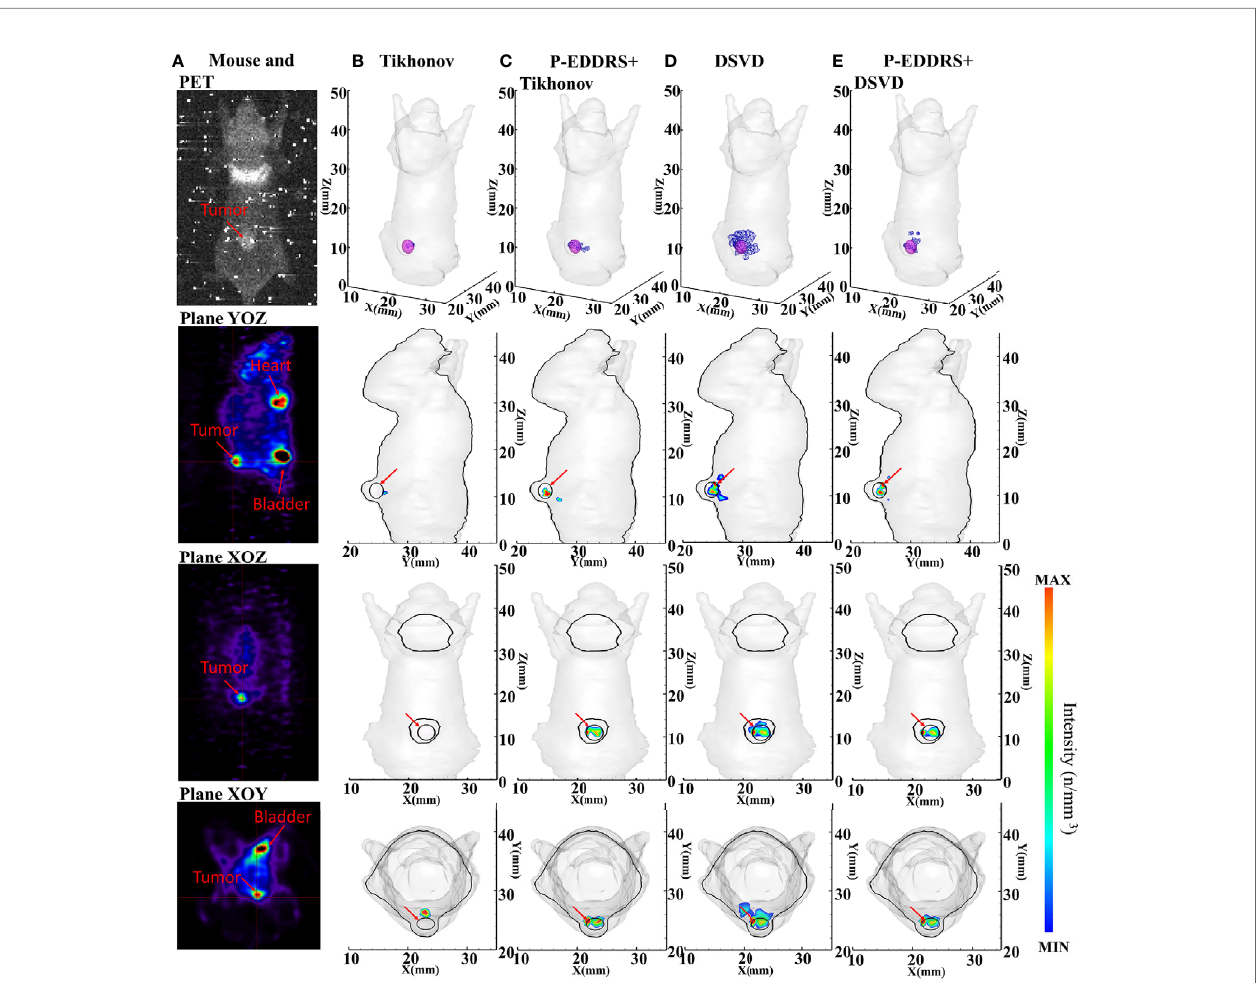
FIGURE 9 | Results of the CLT subcutaneous breast experiments. All results include 3D views and corresponding cross-section views at the plane of X = 22.7, Y = 24.4 mm, and Z = 11 mm. (A) The image collected by the CCD camera; and PET results in YOZ, XOZ, and XOY planes. (B, D) The initial reconstruction results of Tikhonov and DSVD algorithms, respectively. (C, E) The results obtained by the corresponding algorithms of panels (B, D) after using our framework. CLT, Cerenkov luminescence tomography; DSVD, damped singular value